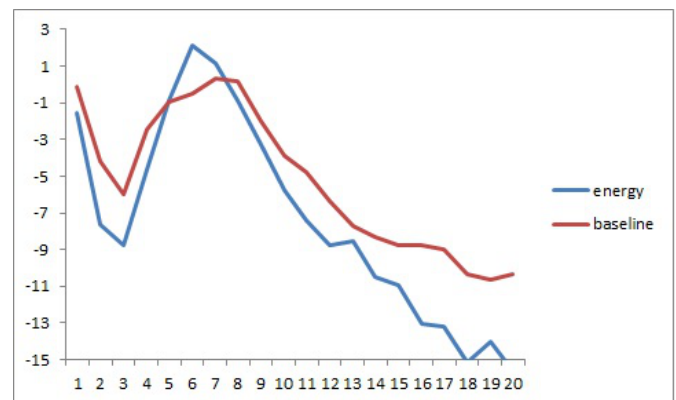
Figure A3. Comparison between energy and aggregate responses for asset prices.